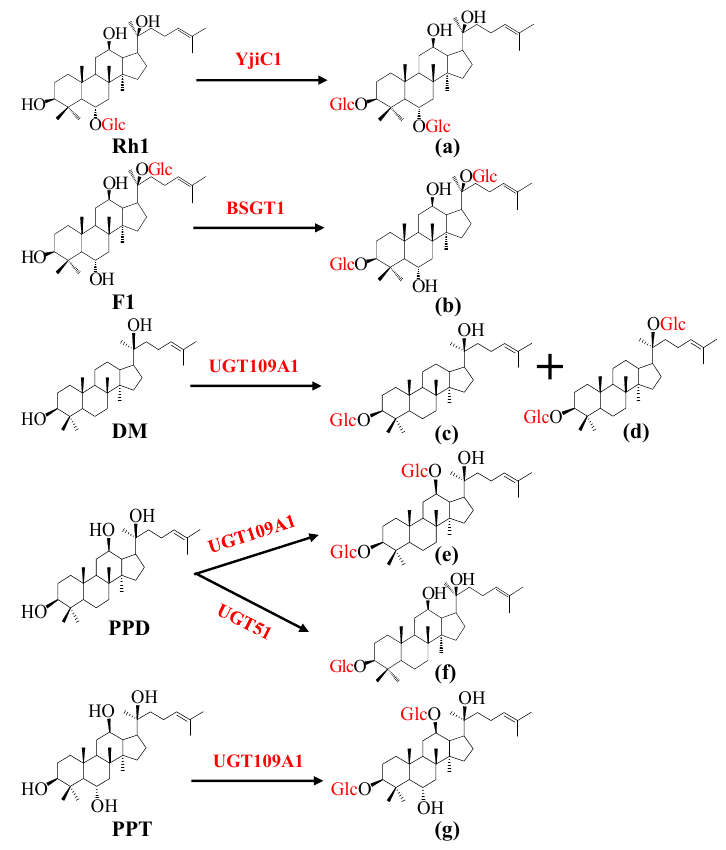
Figure 2. Glycosylation of ginsenosides by UGTs from microorganisms. ( a ) 3- O - β - D -glucopyranosyl-6- O - β - D -glucopyranosyl-20( S )-protopanaxatriol; ( b ) (20 S )-3 β ,6 α ,12 β ,20-tetrahydroxydammar-24-ene-20- O - β - D -glucopyranosyl-3- O - β - D -glucopyranoside (ginsenoside Ia); ( c ) 3- O - β - D -glucopyranosyl-dammar-24-ene-3 β ,20 S -diol; ( d ) 3,20-Di- O - β - D -glucopyranosyl-dammar-24-ene-3 β ,20 S -diol; ( e ) 3,12-Di- O - β - D